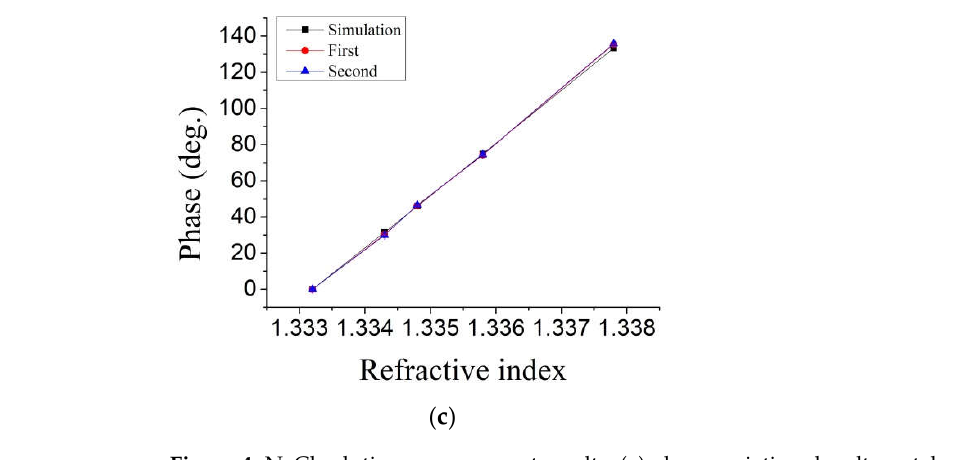
Figure 4. NaCl solution measurement results: ( a ) phase variations by alternately exchanging the pure water and the different NaCl concentrations; ( b ) phase versus concentration for two periods and the simulation results; ( c ) phase versus RI.